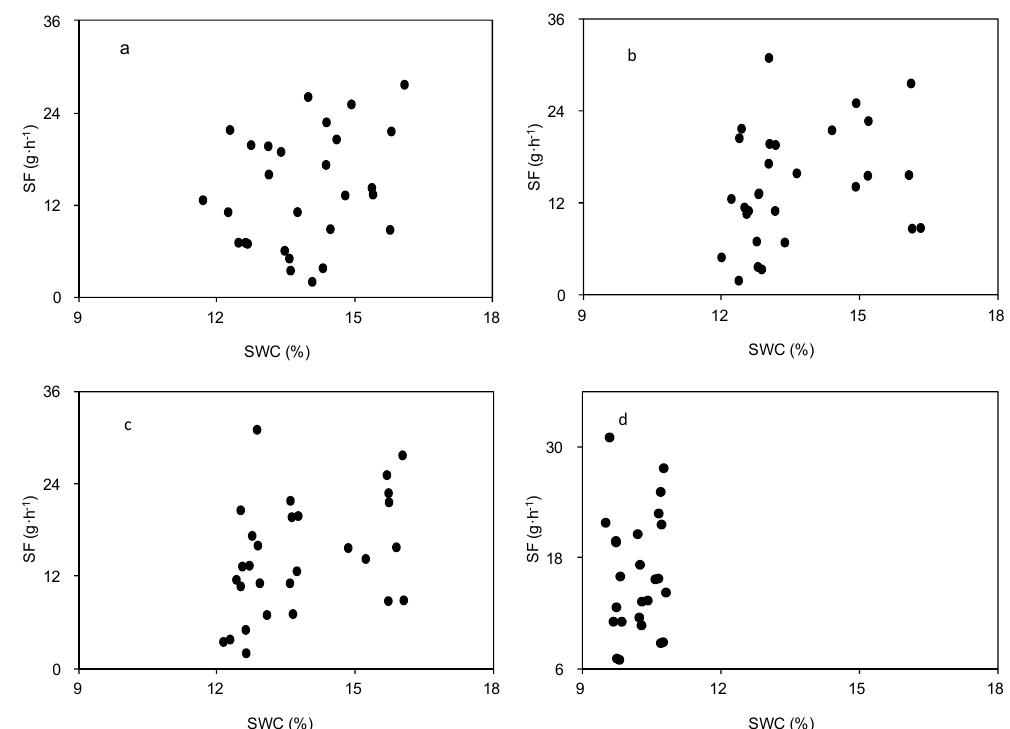
Figure A1. Relationship between SF and soil water content: ( a ) 0–40 cm; ( b ) 40–80 cm; ( c ) 80–120 cm; ( d ) 120–180 cm. y = 5.5609x + 2.0463 R² = 0.1599